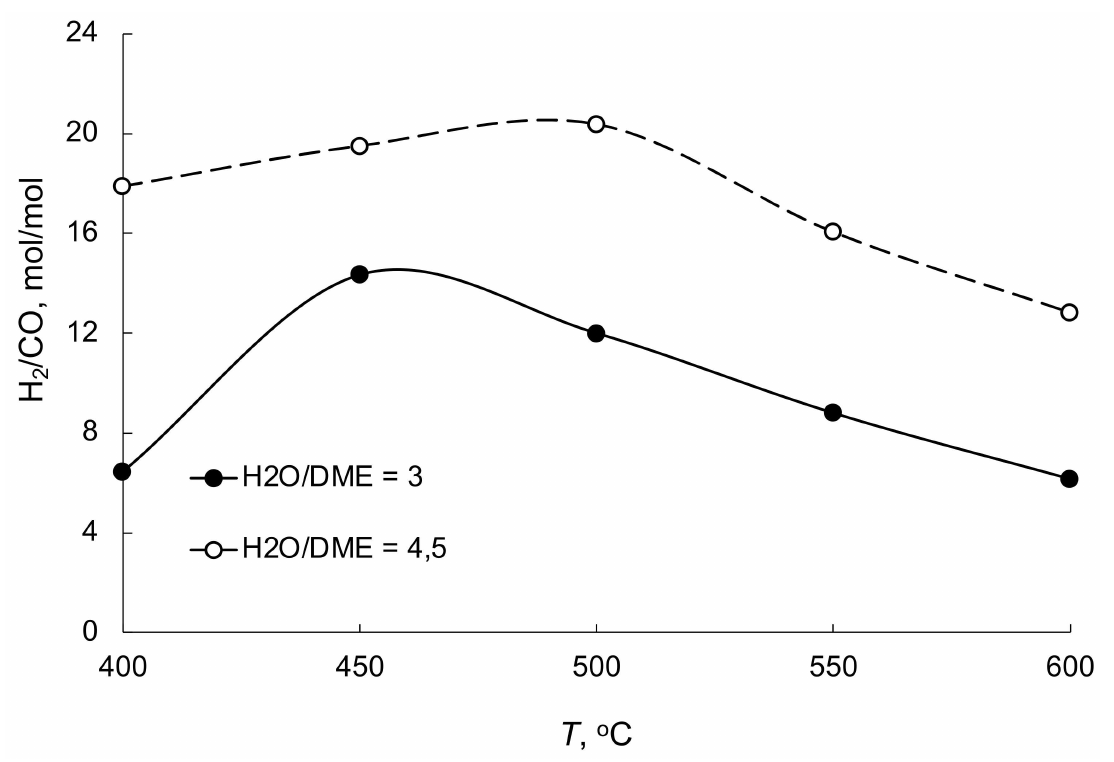
Figure 13. Molar excess of hydrogen over carbon monoxide formed in the process of steam reforming of dimethyl ether carried out at different reactant ratios.